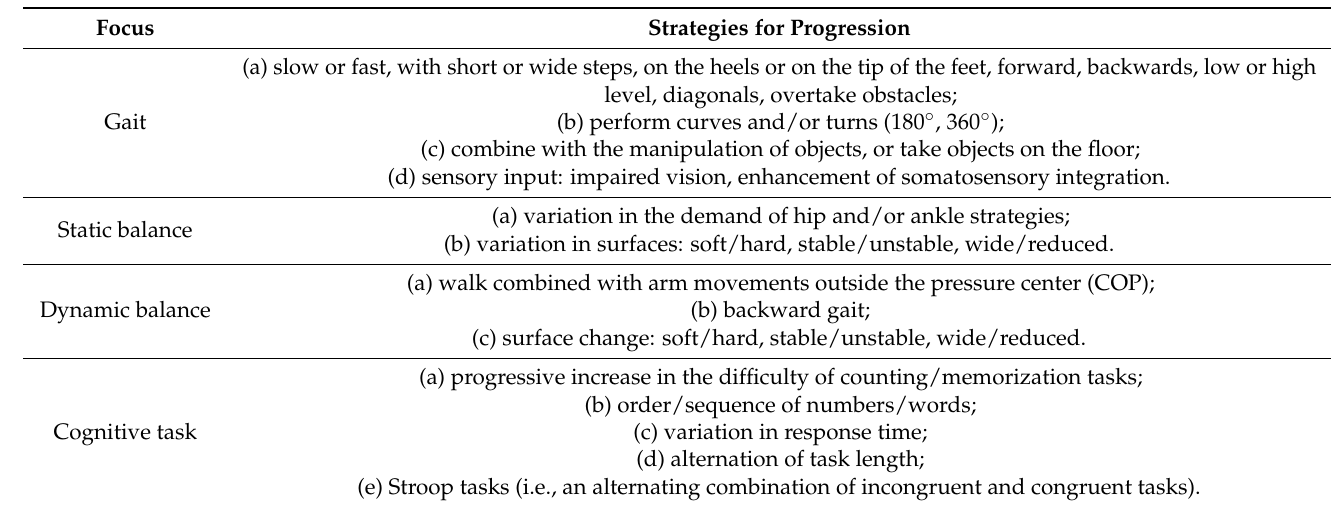
Table 2. Strategies to increase DT training load during gait and balance tasks. Strategies for